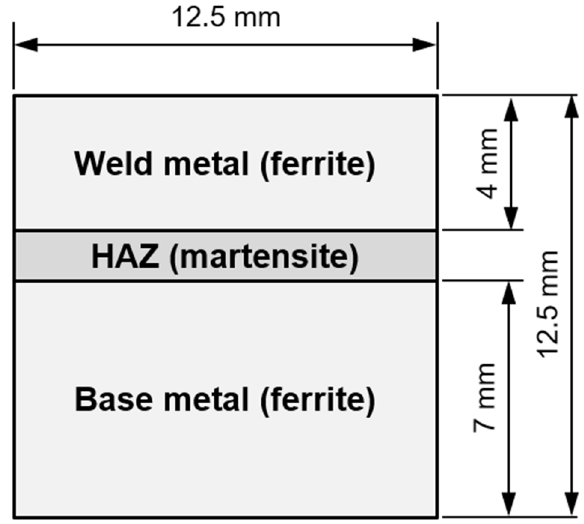
Figure 1. Geometry used for numerical modelling of hydrogen diffusion in the weld; see main text for details.